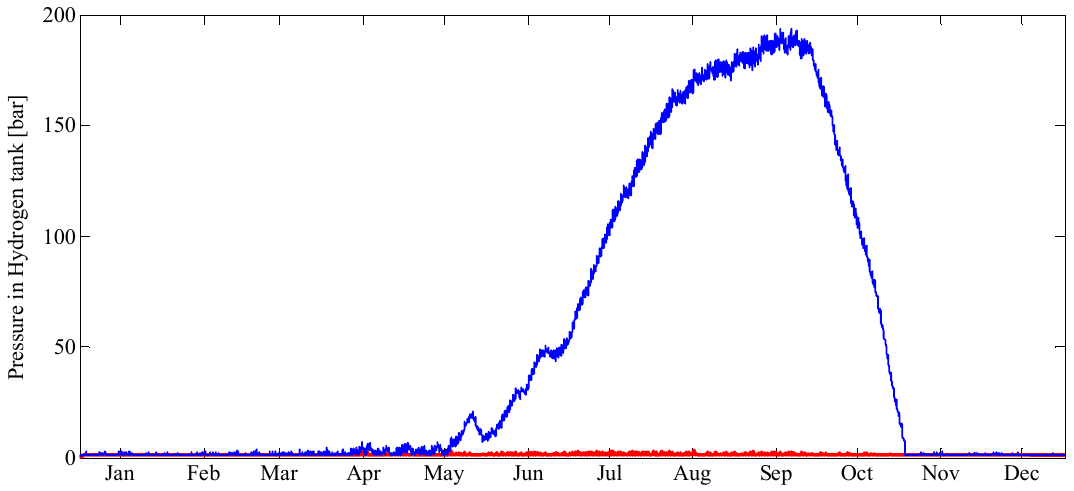
Figure 8. Full (Blue) and partial power mode (Red) of the fuel cell. Full operation has fix quantity hydrogen consumption.